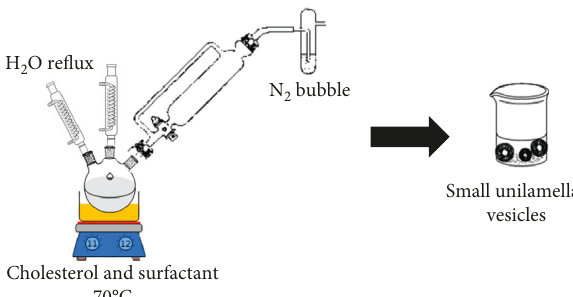
Figure 10: Schematic small unilamellar vesicles (niosomes) formation by bubbling of nitrogen method.